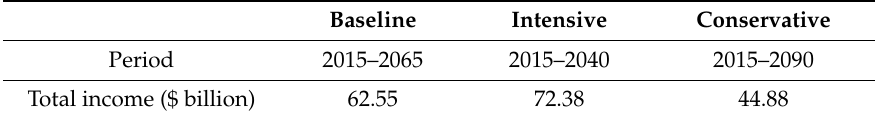
Table 4. Government take during the lifetime of the NG fields in the di ff erent scenarios, in 2018 prices.